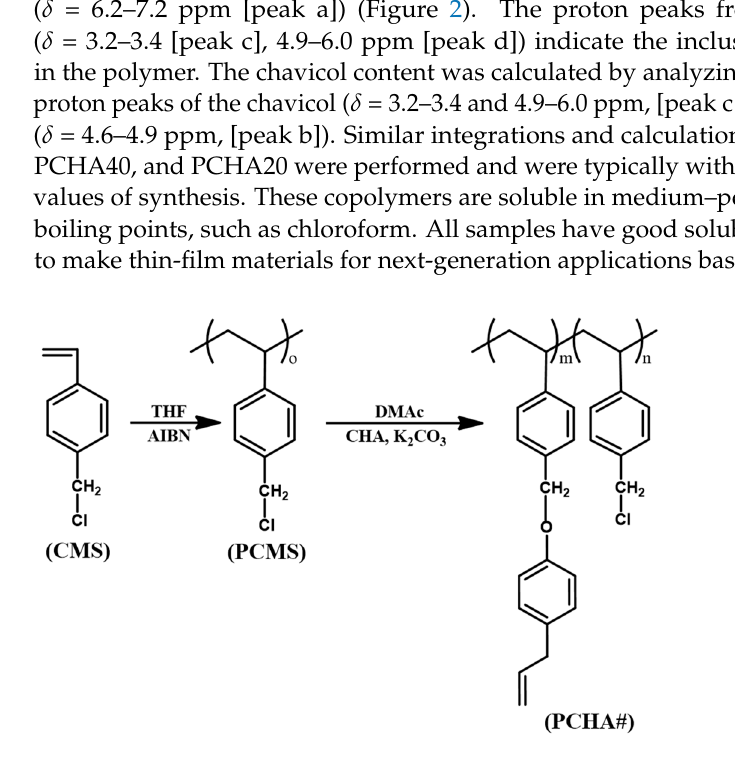
Figure 1. Synthetic route of chavicol-substituted polystyrene films (PCHA#), where # indicates the mole percent of chavicol containing monomeric units in the polymer.